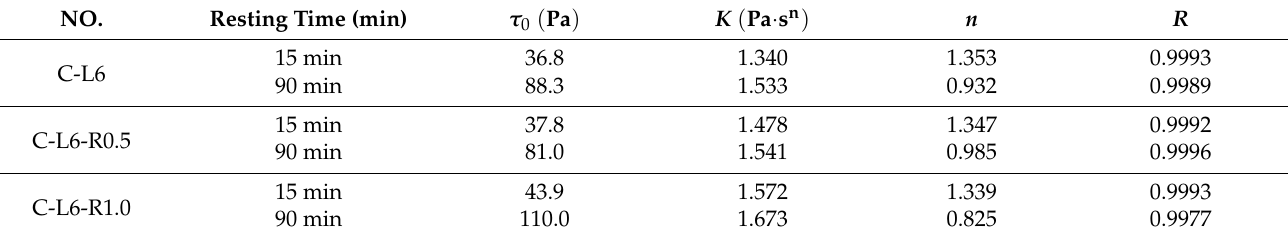
Table 9. Rheological parameters of C-L6-RPP